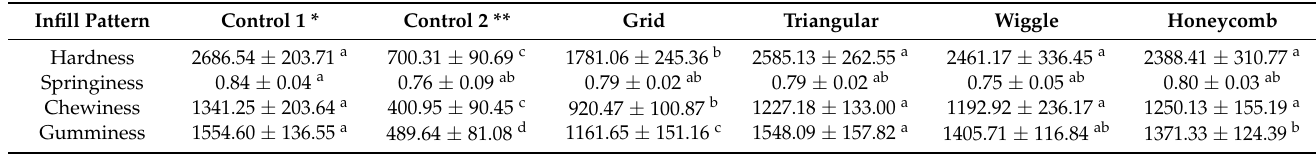
Figure 4. Fried 3D printed samples with different infill patterns (60% infill ratios). Table 5. Texture results of fried 3D printed samples with different infill patterns. Table 5. Texture results of fried 3D printed samples with different infill